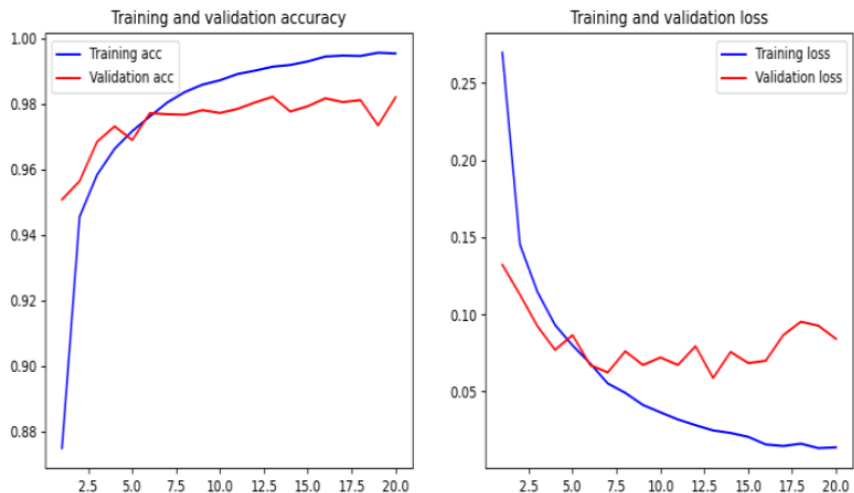
Figure 15. Evaluation of recurrent convolutional neural network (RCNN) model on D2 using FG2.